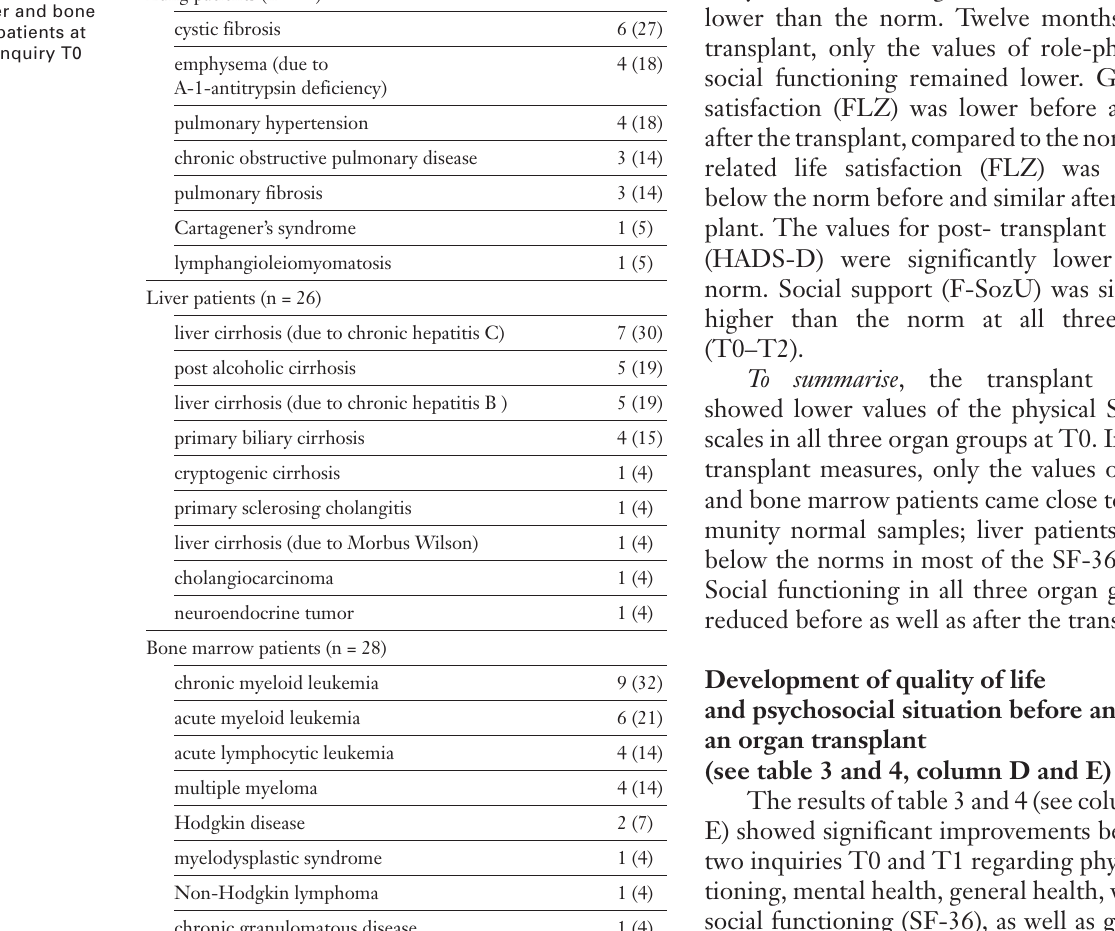
Diagnoses of the lung, liver and bone marrow patients at the first inquiry T0 (n =